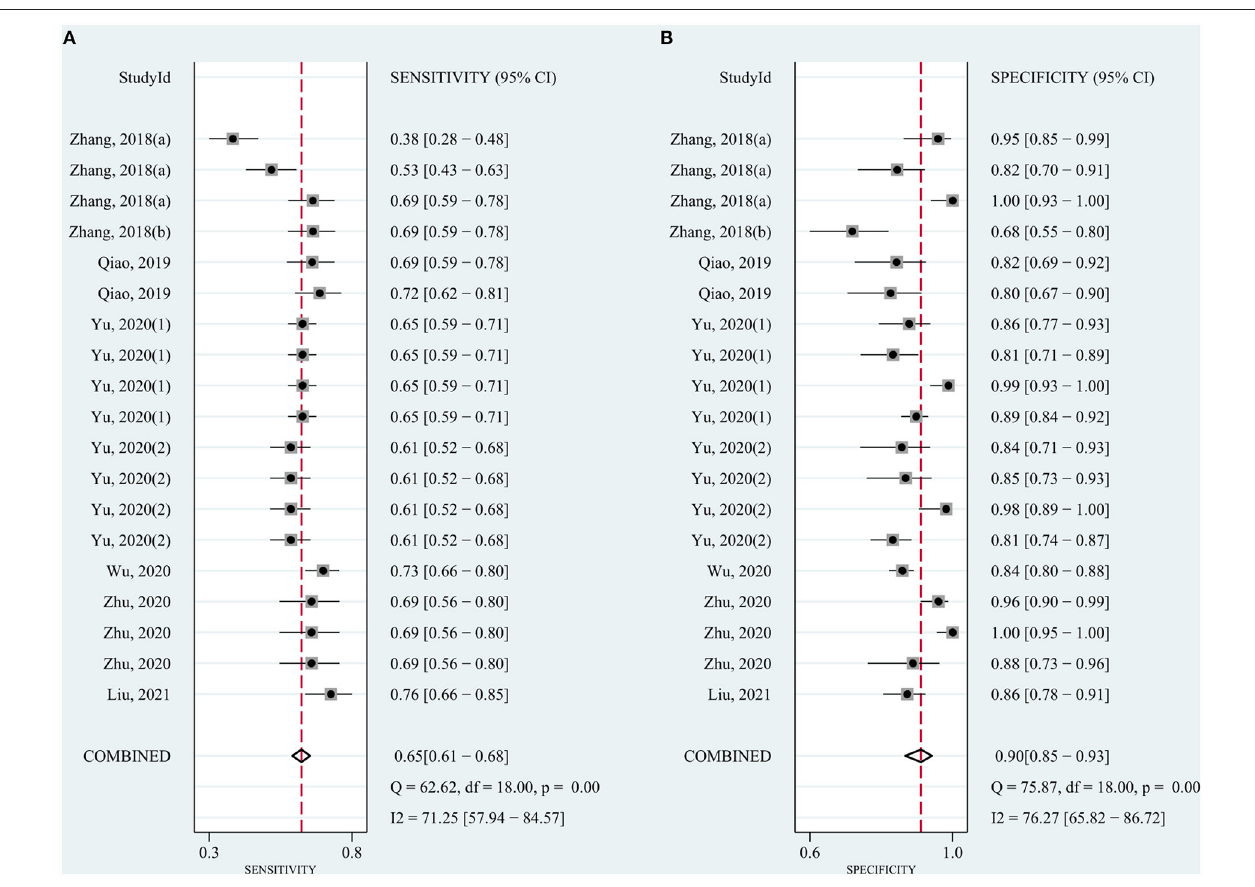
FIGURE 3 | Forest plots for diagnostic accuracy of AFP in hepatocellular carcinoma (HCC). (A) Sensitivity. (B) Specificity.